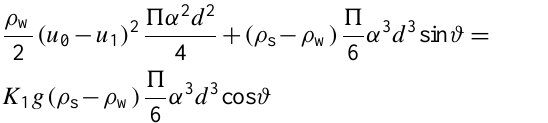
Figure 2. Non-dimensional moving layer depth, h expressions developed for steady flows. Values of slope, friction angle and diameter used for the estimation are shown in the figure.